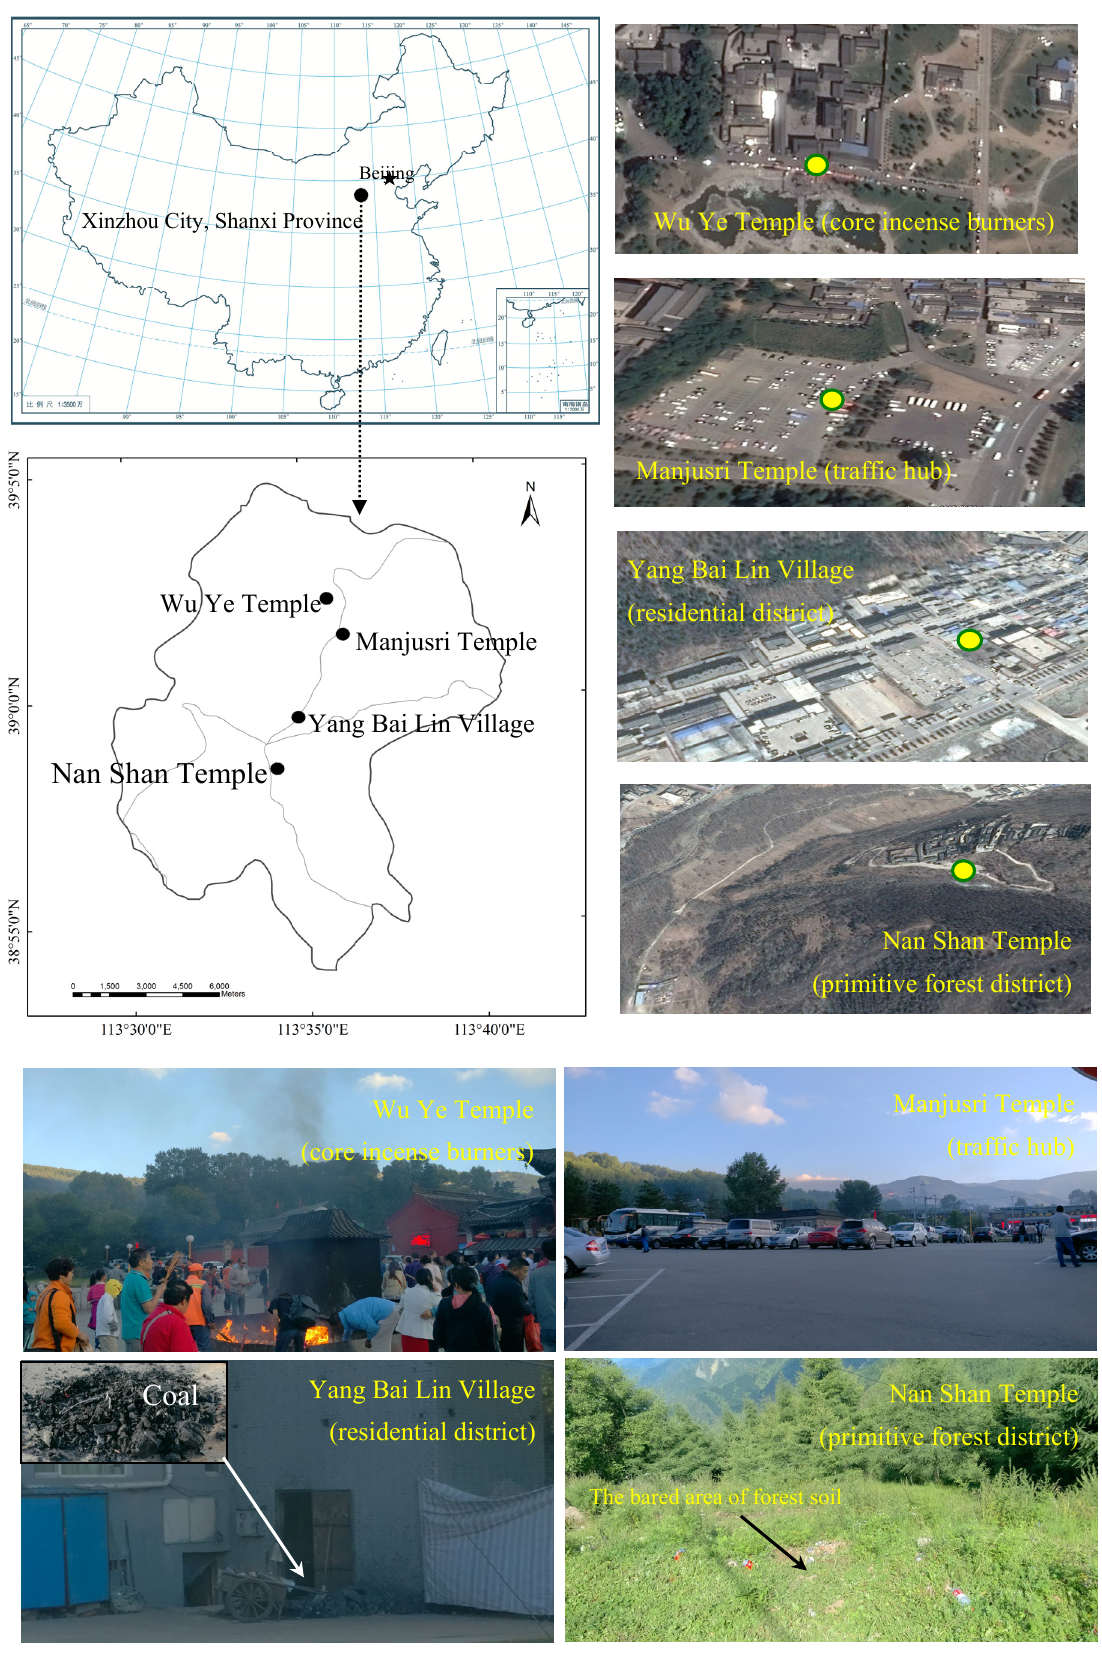
Figure 1. Distribution of sampling sites and its real scene pictures in the four different areas at Mount Wutai, Shanxi,